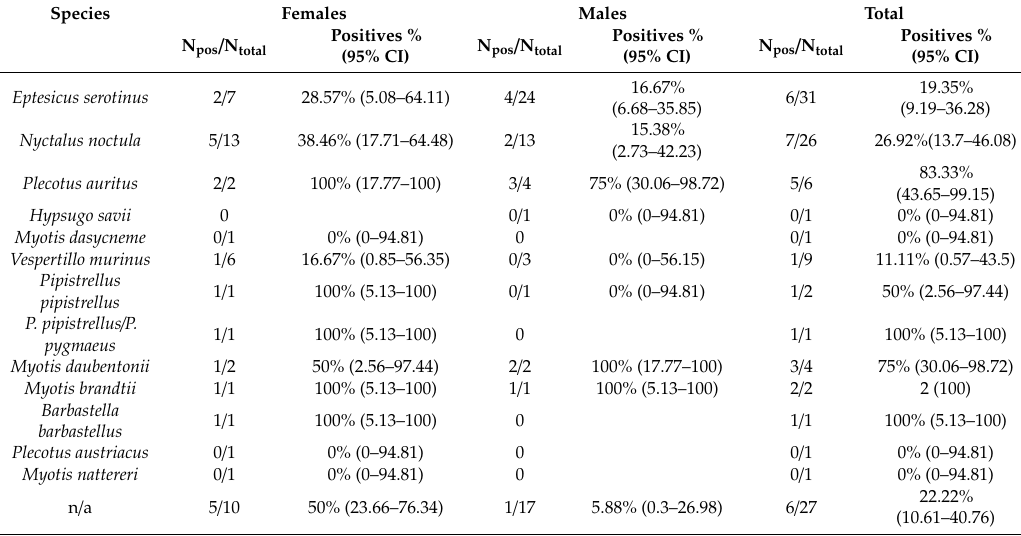
Table 1. Results of the serological survey of Polish bats (2012–2018) on lyssavirus-specific antibodies using the BioPro Rabies ELISA Ab kit. CI—confidence